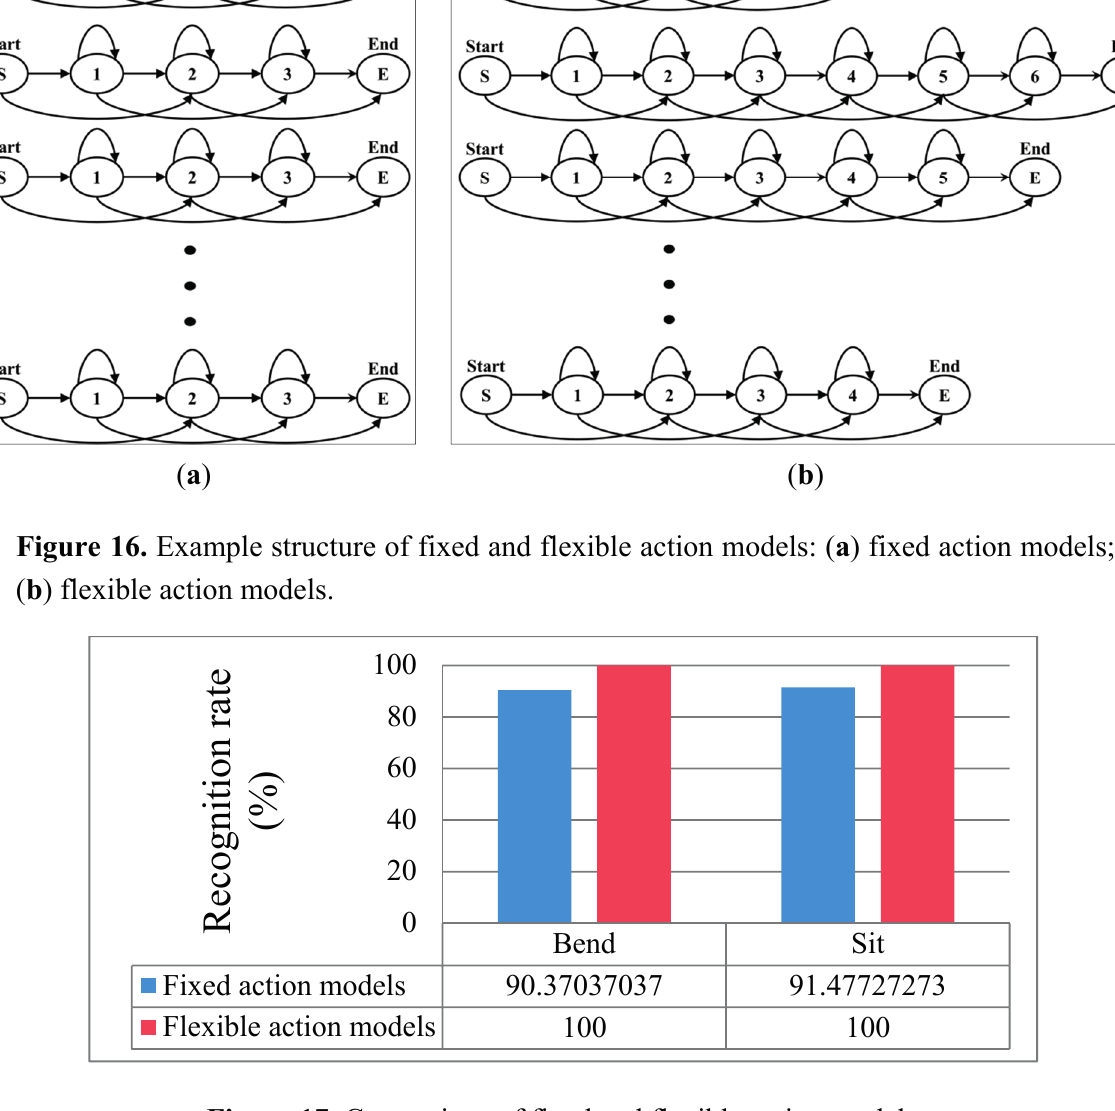
Figure 17. Comparison of fixed and flexible action